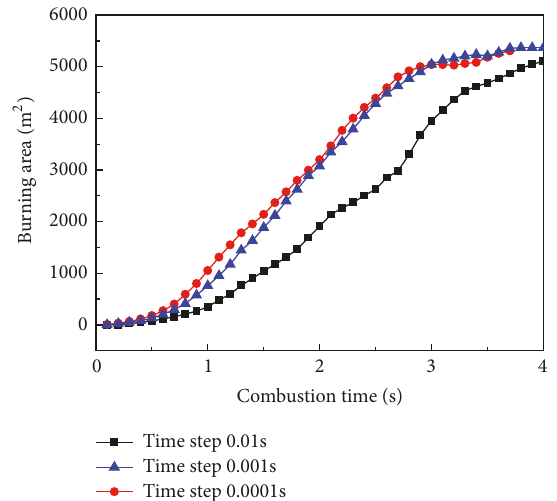
Figure 8: Comparison of different time steps in deflagration simulation.